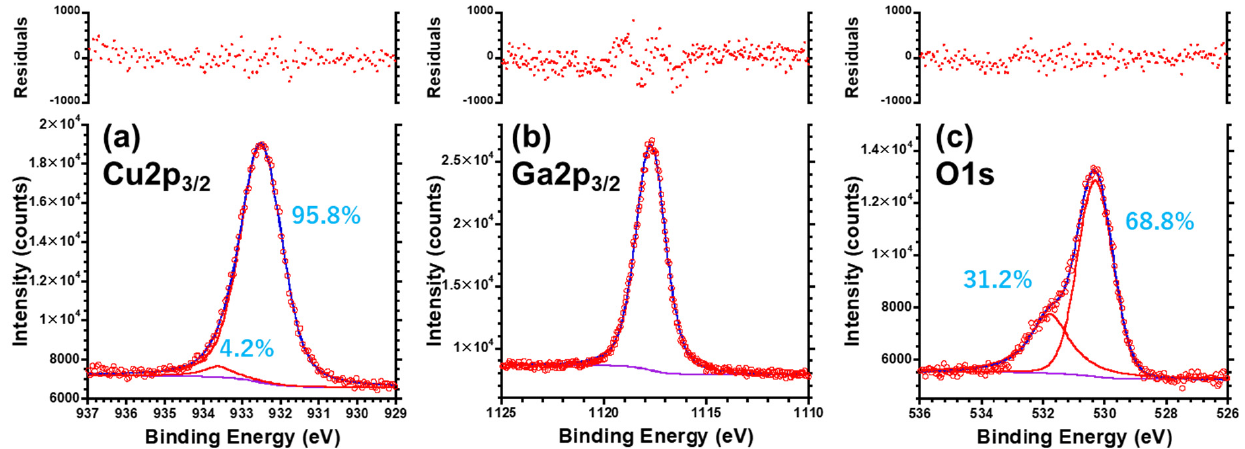
Figure 8. XPS spectra of ( a ) Cu 2 p results using Voigt functions. The fitting results are summarized in Table 3.